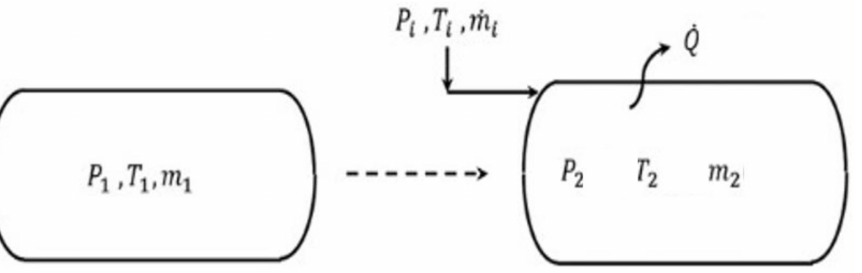
Figure 3. Simplified high-pressure tank